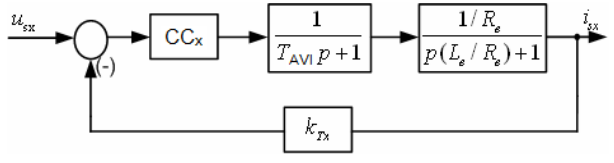
Figure 2. Structure diagram of the loop for stator current component control Considering the loop parameters a proportional-integral (PI) controller has been